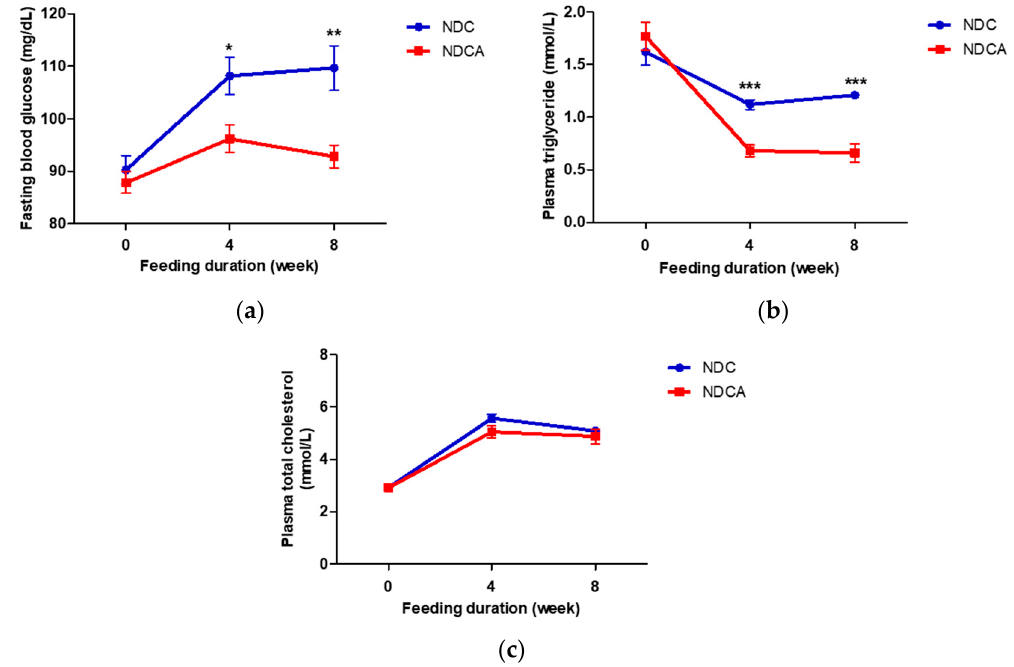
Figure 4. Effect of supplementation of a non-dairy creamer-enriched high-fat diet with D-allulose on time course changes in fasting blood glucose, plasma triglyceride, and total cholesterol in C57BL/6J mice fed high-fat diet for 8 weeks: ( a ) fasting blood glucose; ( b ) plasma triglyceride; ( c ) plasma total cholesterol. Data are mean ± SE. Significant di ff erences between the 5% D-allulose group and without D-allulose group are indicated; * p < 0.05, ** p < 0.01, *** p < 0.001. NDCA, high-fat diet with non-dairy